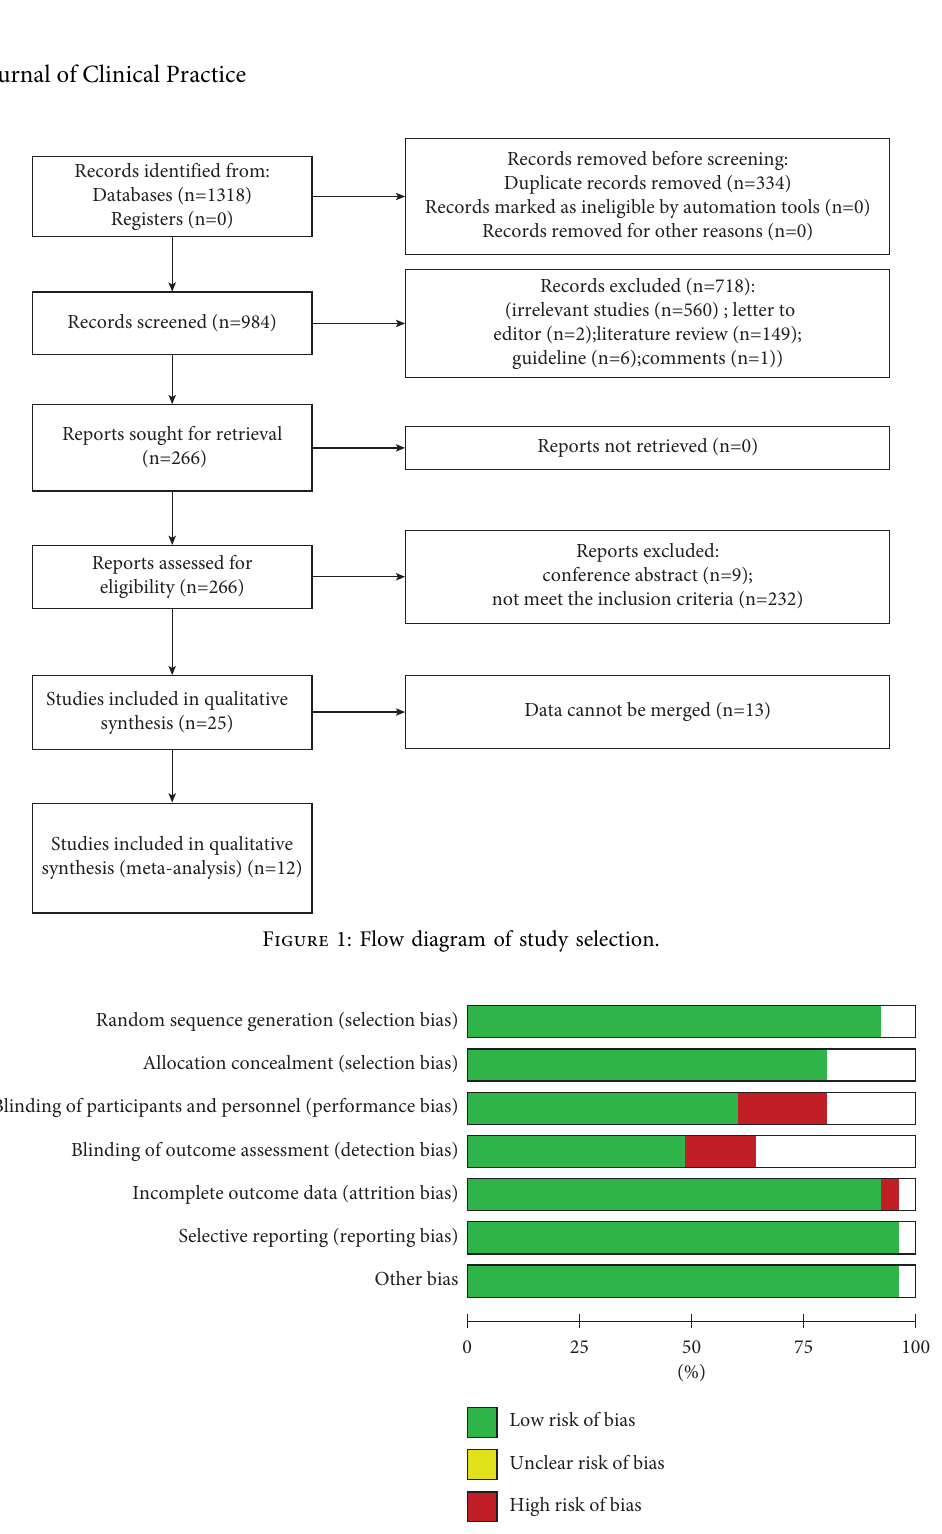
Figure 2: Risk of bias